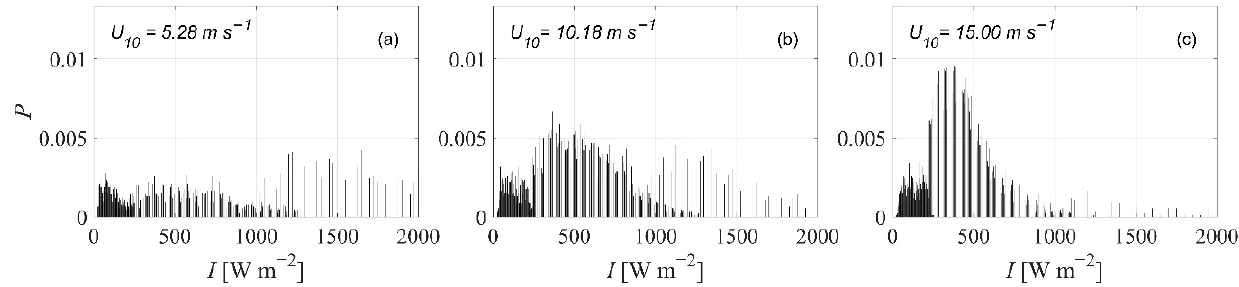
Figure 4. ( a ) An example of the probability density distribution of the attenuated laser intensity I for a 5 m s − 1 wind speed event. ( b , c ) Same as ( a ) but for a 10 m s − 1 and 15 m s − 1 wind speed event, respectively.